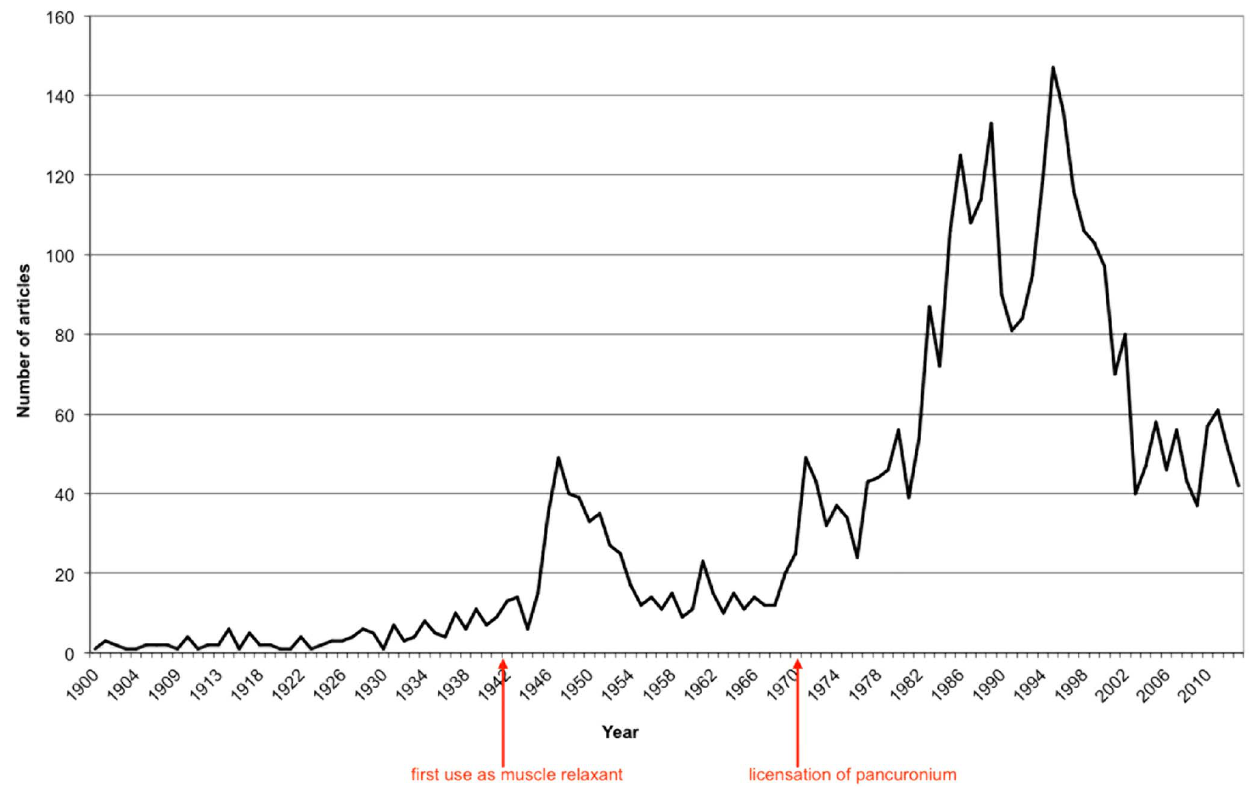
Figure 1. Articles by years.